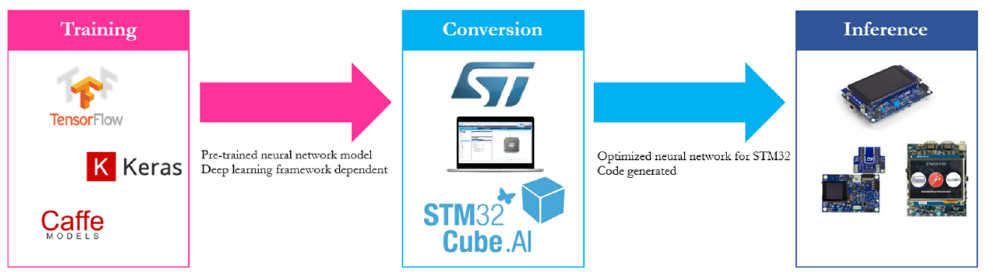
Figure 2. Conversion of a pre-trained model using STM32CubeMX.AI.